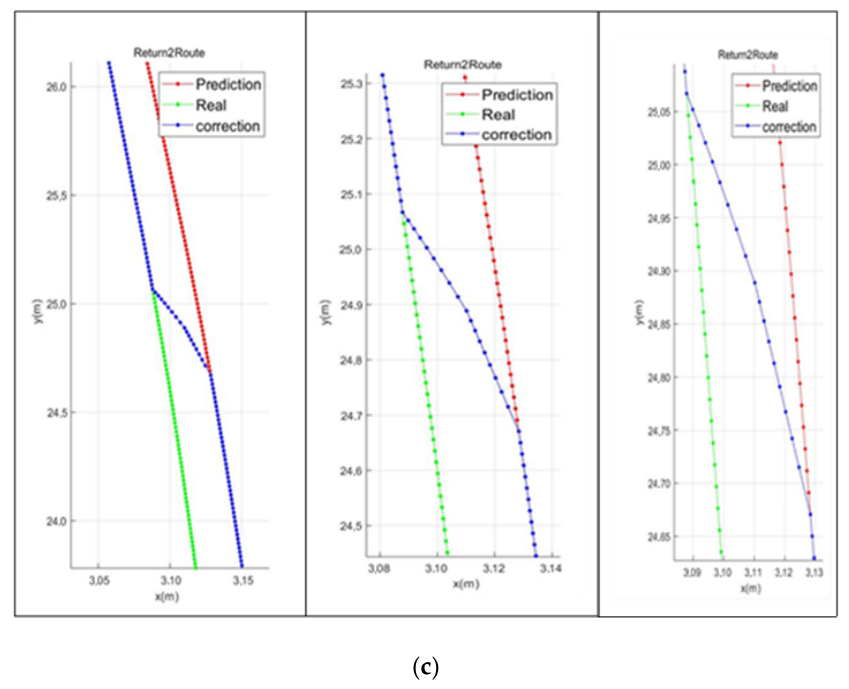
Figure 10. Experimental results in case of ( a ) actual coordinates slower than expected. ( b ) Actual coordinates to the right of expected coordinates. ( c ) Actual coordinates to the left of expected coordinates.